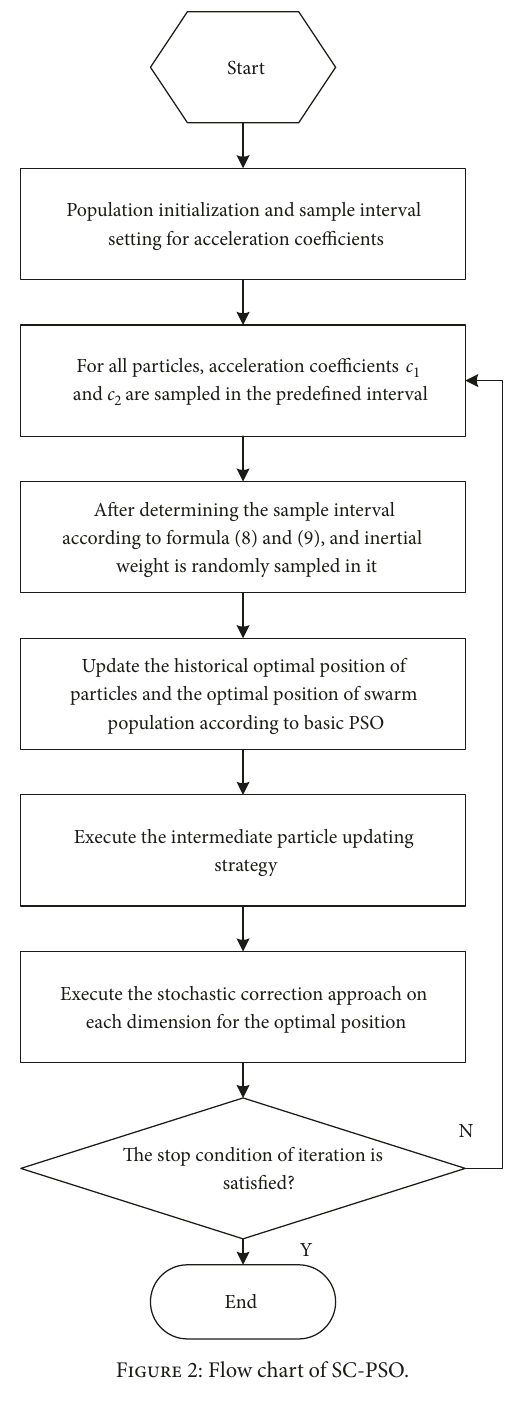
Figure 2: Flow chart of SC-PSO.